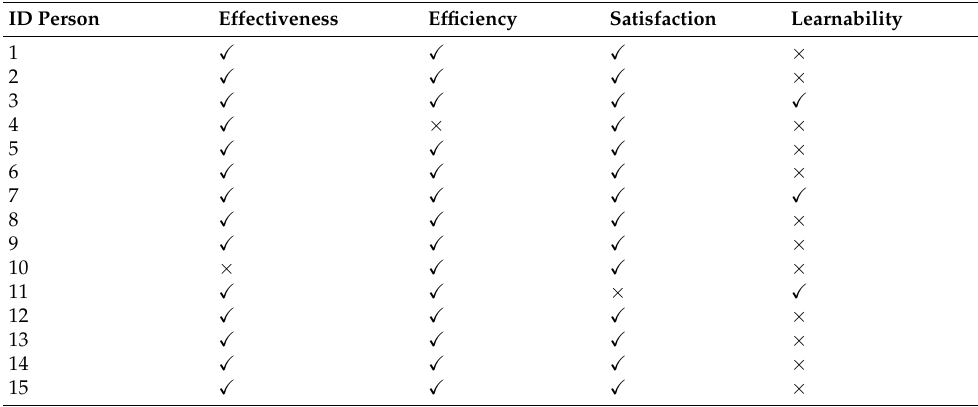
Table 17. Older people who made use of sensor system in their